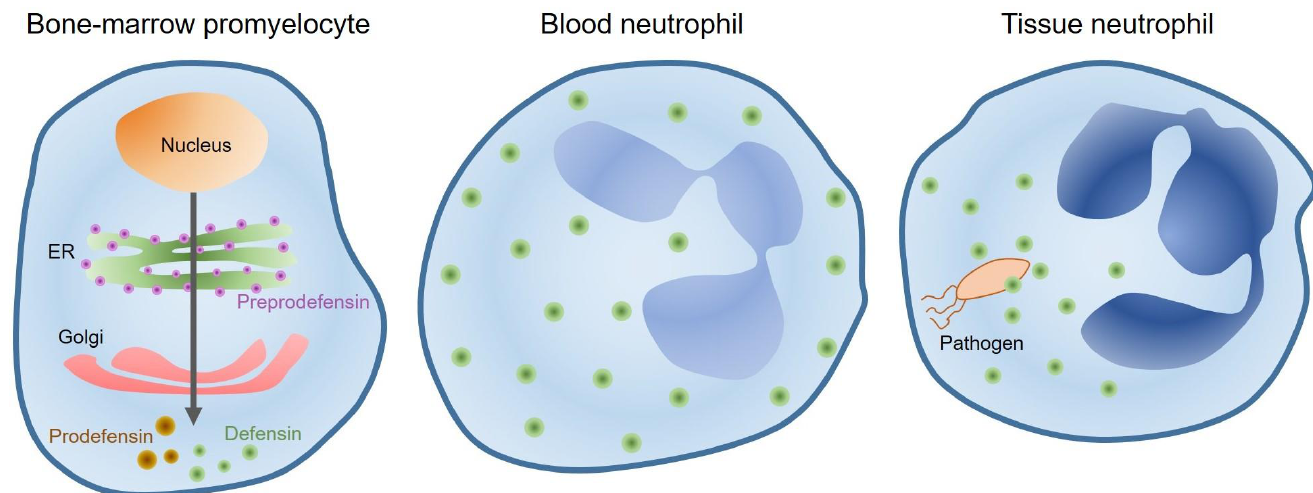
Figure 5. Promyelocytes in the bone marrow synthesize α-defensins. 94 amino acid preprodefensin (purple) is biosynthesized in the ribosomes; the 19 amino-acid N-terminal signal sequence is cleaved and it converted to a 75 amino-acid prodefensin (brown). Subsequent cleavage of residues generates a 29–30 amino acid mature defensin (green). During phagocytosis (pathogens), defensin-rich primary granules fuse with phagocytic vacuoles and high concentrations of defensins are gen- erated.